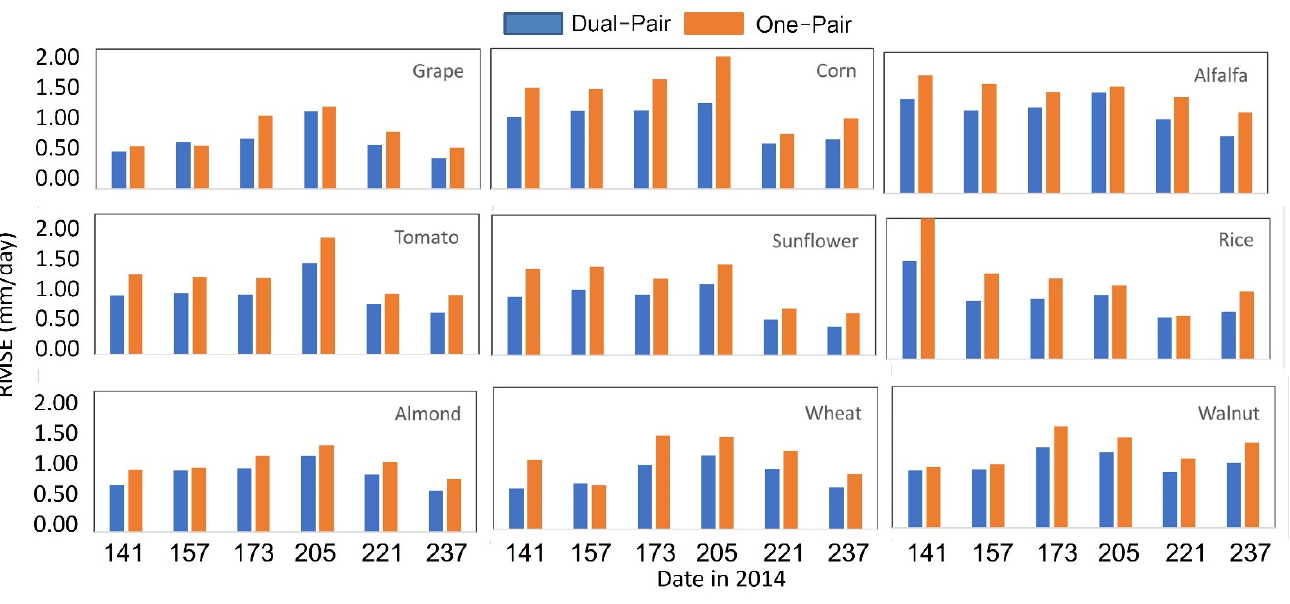
Figure 7. Comparison of RMSE between dual-pair and one-pair for the tested Landsat overpass days in 2014 for major crop types.